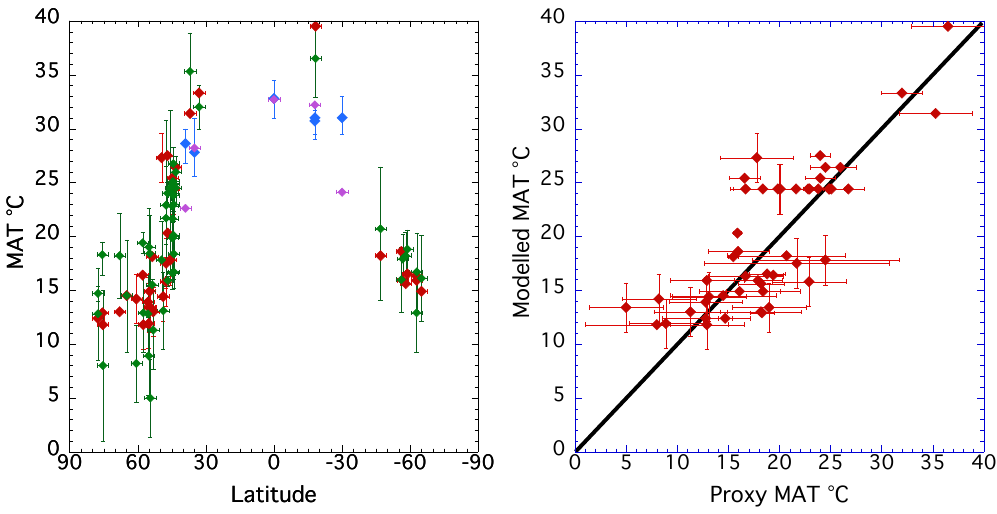
Fig. 4. On the left, a pointwise comparison of annual mean terrestrial surface temperature (MAT) from EOCENE-4480 (red) and proxy data estimates (green) versus latitude. The vertical error bars on the proxies represent the methodological error plus the temporal variation (if a time series) as further described in the text. The model vertical error bars are only included in regions considered to have high elevation and represent topographic uncertainty as described in the text. Horizontal error bars indicate the uncertainty in the position of the paleolocality and the propagation of that uncertainty onto the discrete model grid (as described in the text). A comparison is also made for reference of tropical SSTs (reconstructed in blue and modelled in magenta). The tropical reconstructions follow those in Huber (2008) with the exception of the Tanzanian (19 South latitude) TEX 86 data which were recalculated using the Liu et al. (2009) calibration. It should be noted that the potential uncertainty is underestimated, since only one set of calibrations was used for each proxy and therefore a major source of uncertainty is ignored. On the right, the temperatures reconstructed from terrestrial proxies are plotted versus modelled and the 1-to-1 line is plotted in black. The error bars are the same as previously described.